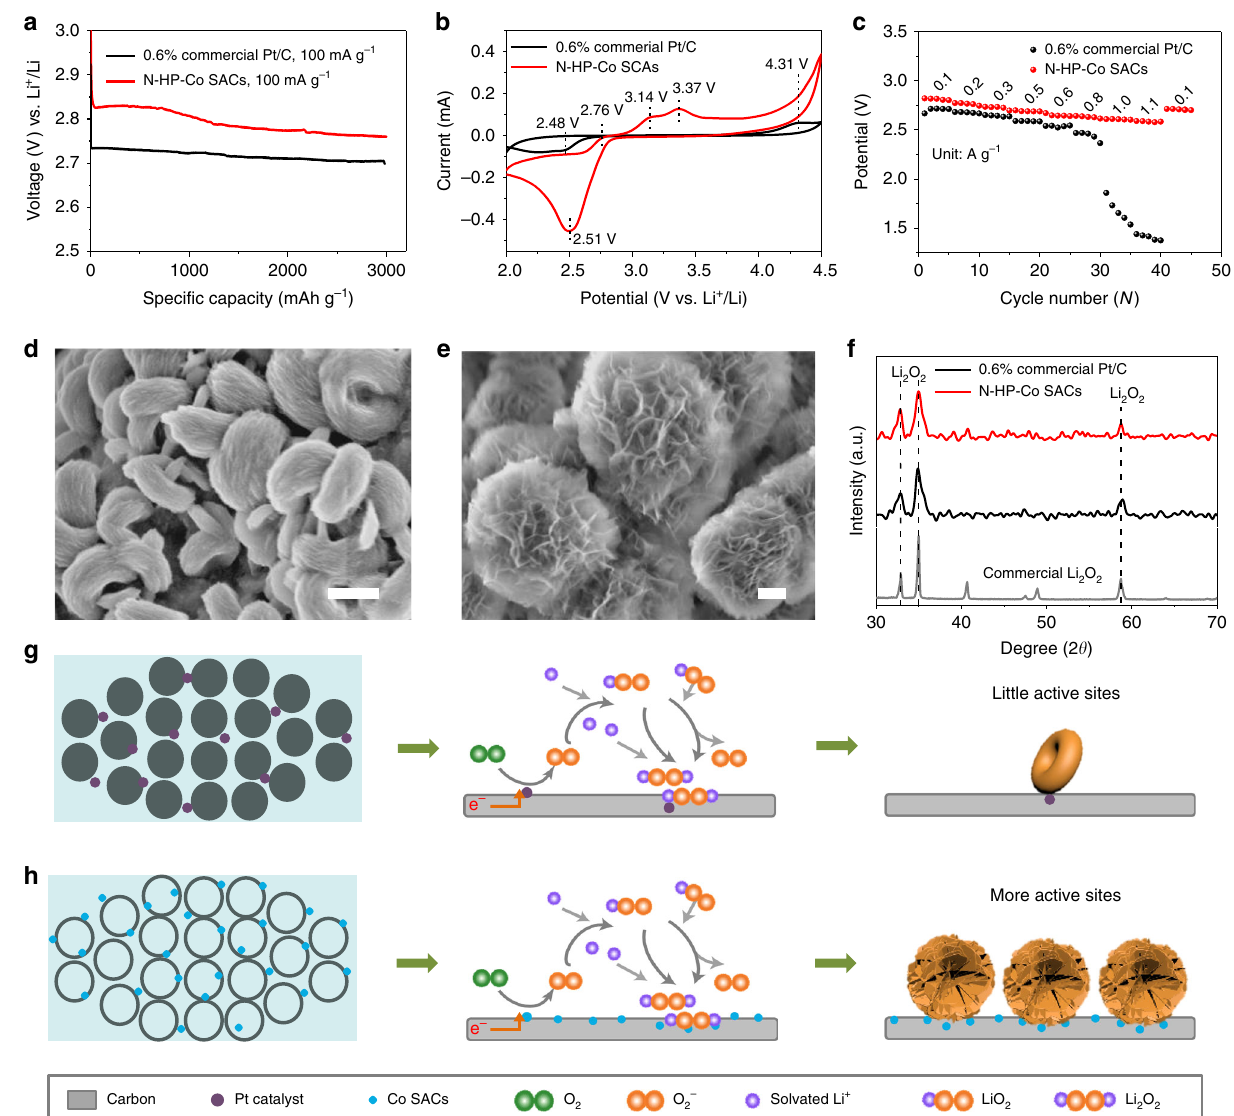
Fig. 4 Discharge performance and characterization of discharge products. a First discharge curves with 0.6% commercial Pt/C and N-HP-Co SACs at a current density of 100 mA g − 1 with a limiting speci fi c capacity of 3000 mAh g − 1 . b CV curves. c Full range rate performances of Li – O 2 batteries at different current densities. d , e FESEM images of the discharged cathodes with ( d ), 0.6% commercial Pt/C and ( e ) N-HP-Co SACs at a current density of 100 mA g − 1 with a limiting speci fi c capacity of 3000 mAh g − 1 , 500 nm in ( d , e ); f The corresponding XRD patterns. The standard spectra for Li 2 O 2 are also shown for reference. Discharge mechanism of 0.6% commercial Pt/C ( g ) and N-HP Co SACs ( h ) in the Li – O 2